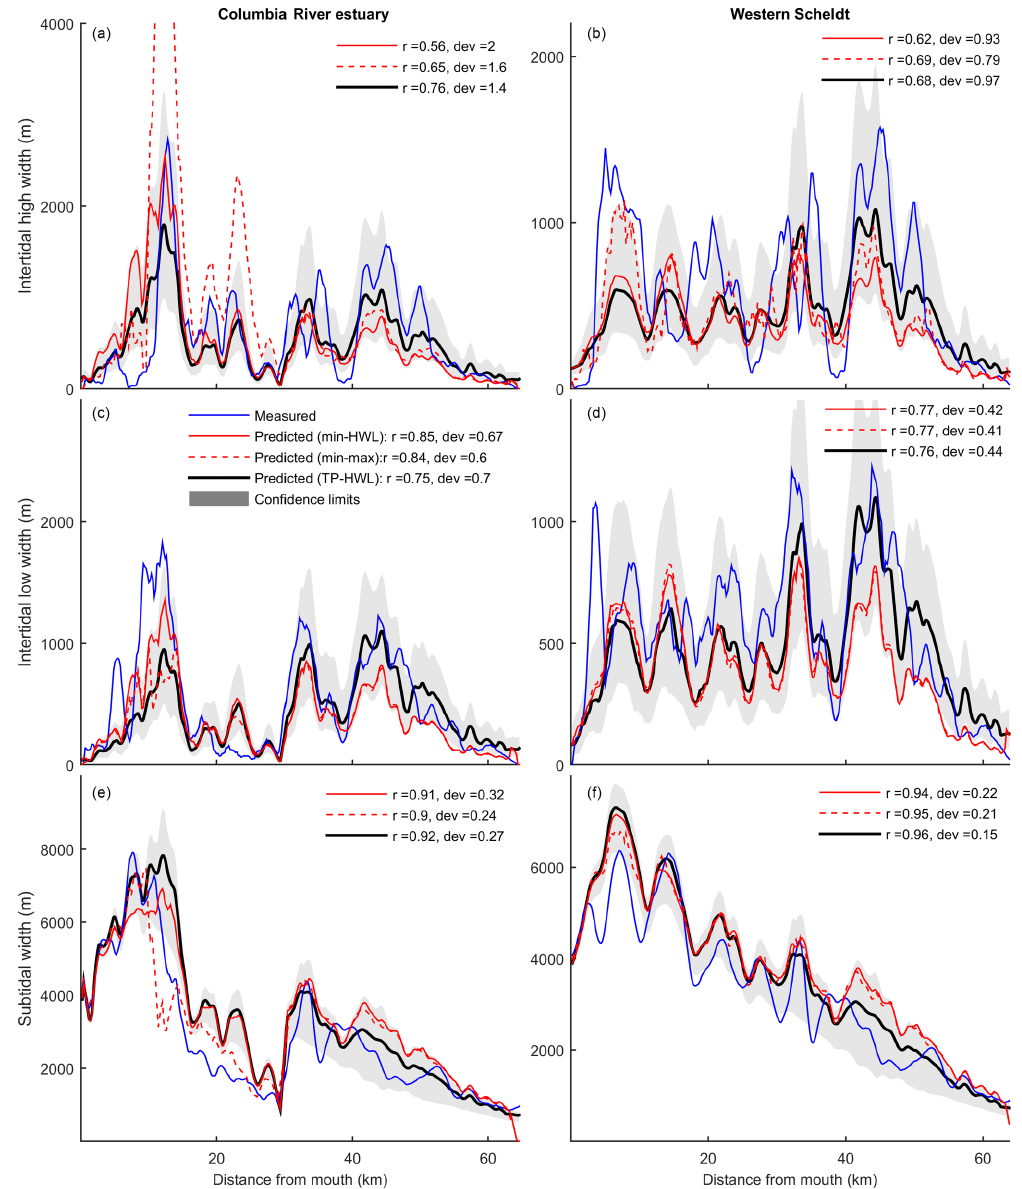
Figure 10. Comparison of measured and predicted values of intertidal high, intertidal low and subtidal width for the Columbia River Estuary (a, c, e) and the Western Scheldt (b, d, f) . Predicted nondimensional hypsometry was dimensionalised for each cross section using three methods (explained in Methods) and uncertainty margins are given for one of the predictions (solid black line). In the legend, r indicates the Pearson product-moment correlation coefficient and “dev” the average factor of deviation between the predicted (TP-HWL) and measured